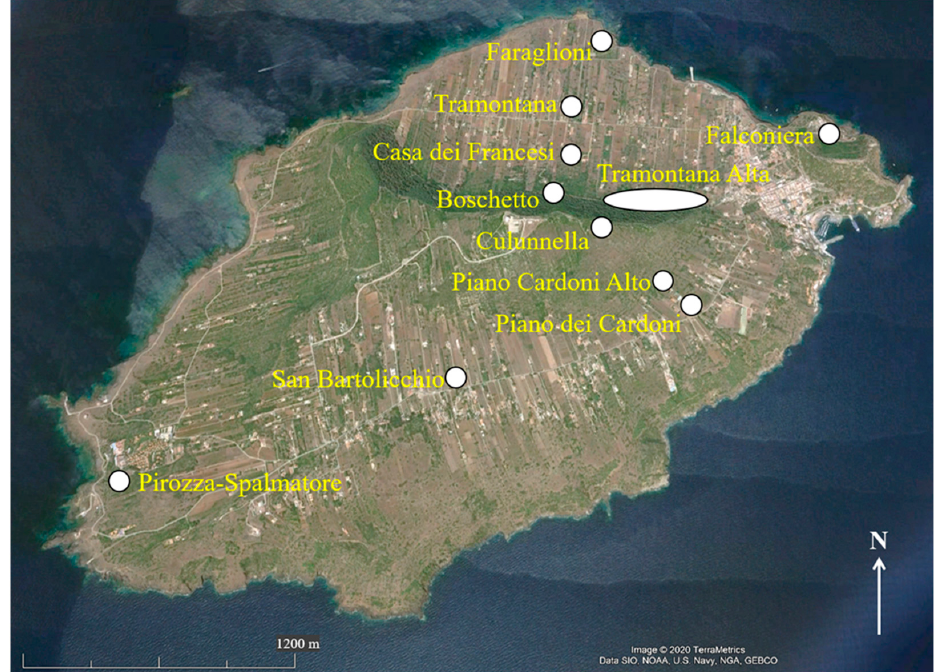
Figure 12. Map with directions to archaeological sites with Palmarola obsidian artifact attributions, including across the Adriatic.